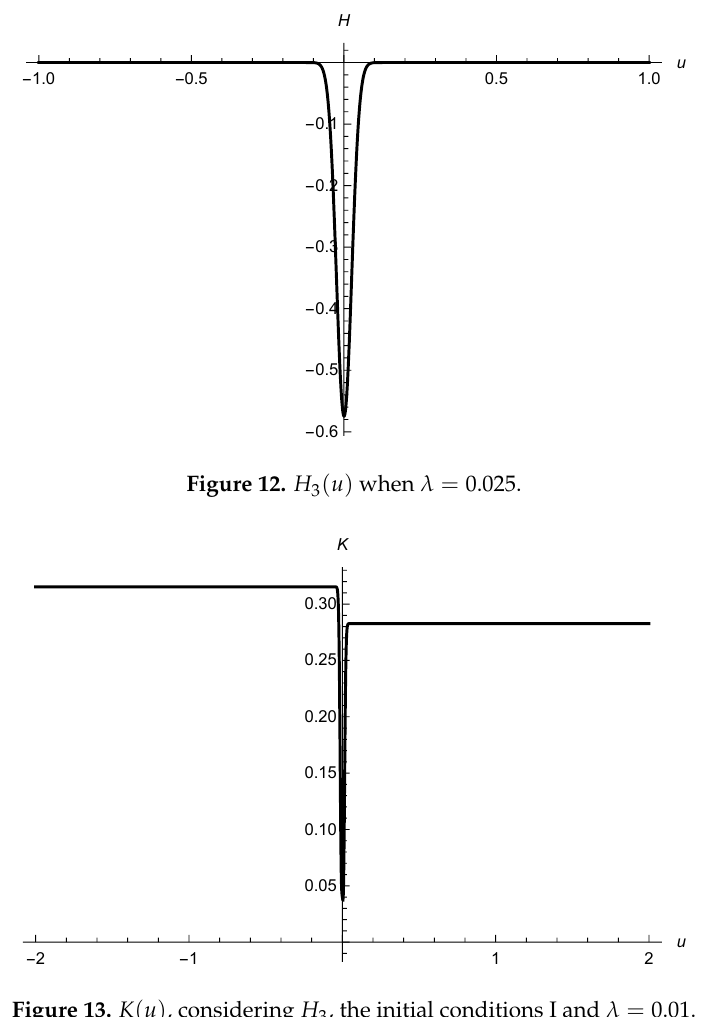
Figure 13. K ( u ) , considering H 3 , the initial conditions I and λ = 0.01.